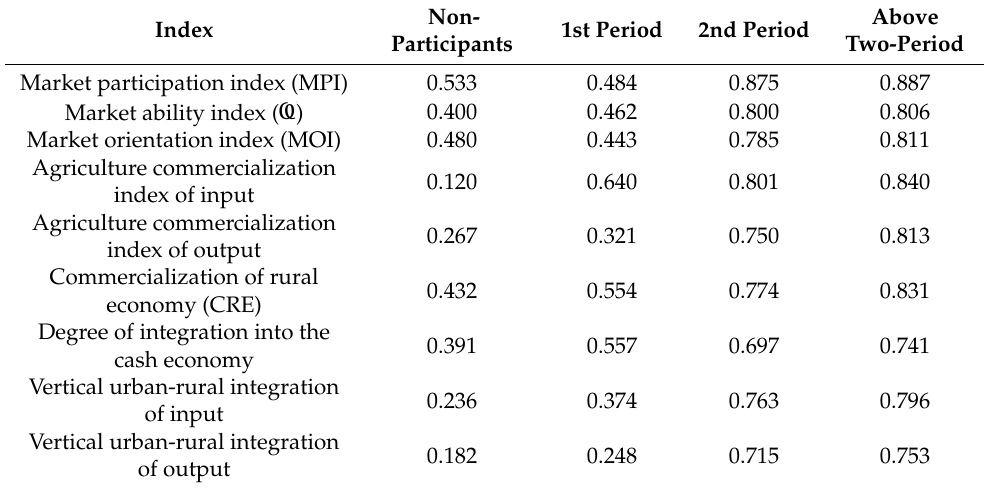
Table 5. The extent of market participation and commercialization—urban-rural integration.